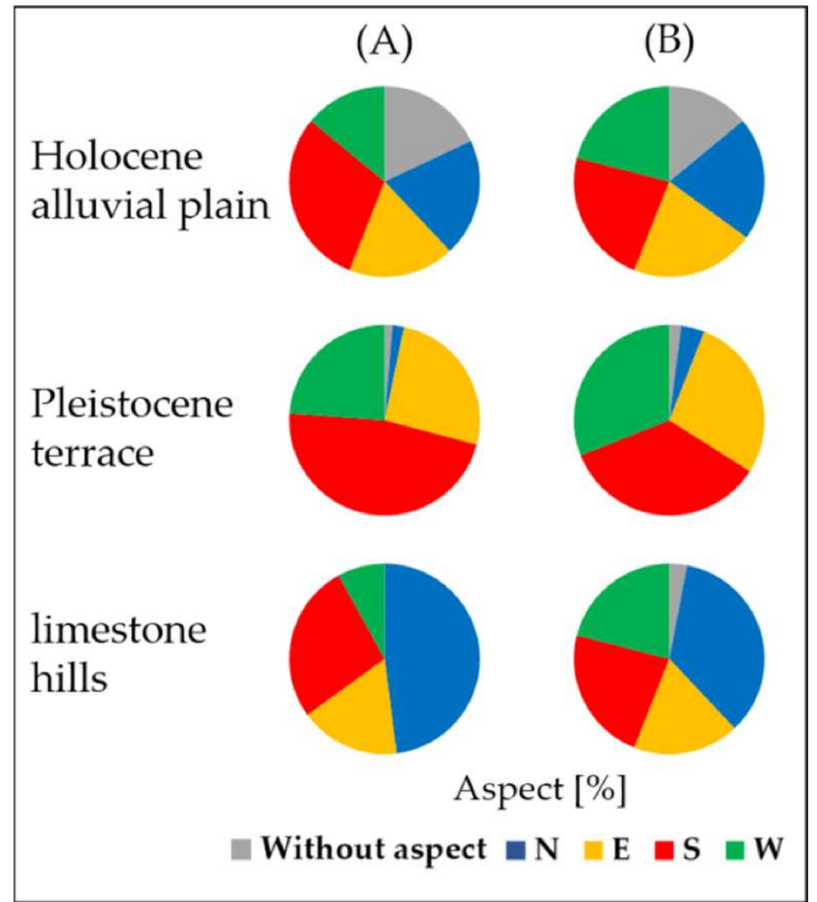
Figure 6. Percent of area without aspect and with N, E, S and W aspect concerning the Holocene allu- vial plain, Pleistocene terrace and limestone hills in time variants ( A , B ), based on the third